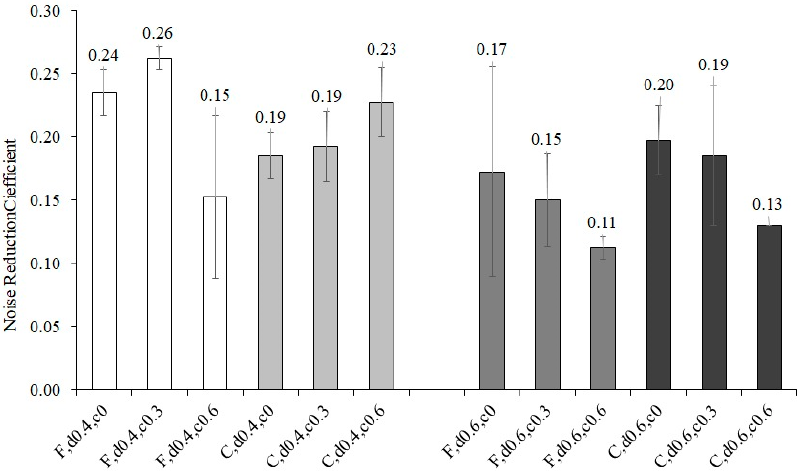
Figure 11. Noise reduction coefficient of various PU coating thickness in fine and coarse particle for 0.4 g/cm 3 and 0.6 g/cm 3 . Table 6. Analysis of variance (ANOVA) of NRC on bamboo particle board which coating treatment.